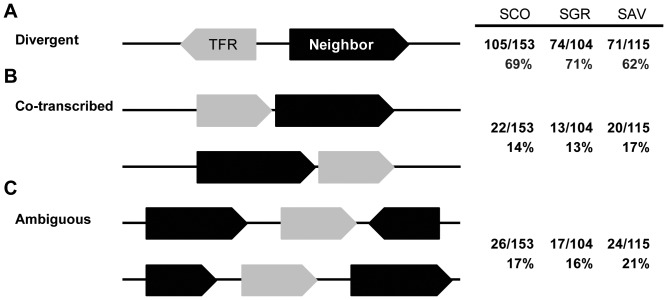
Classification of TFRs according to their relative orientation to the neighboring genes.372 TFRs in S. coelicolor (SCO, 153 TFRs), S. griseus (SGR, 104 TFRs), and S. avermitilis (SAV, 115 TFRs) were divided into three groups according to their genome context to neighbors. (A) 250 TFRs (105 in SCO, 74 in SGR, 71 in SAV) are encoded divergently to their neighbors. Here, a TFR-encoding gene is located on the left side for visualization purpose, but the positions of this gene and its divergent neighbor are interchangeable. (B) 55 TFRs (22 in SCO, 13 in SGR, 20 in SAV) are likely co-transcribed with their upstream or downstream genes as the intergenic DNAs separating them are ≤35 bp. (C) 67 TFRs (26 in SCO, 17 in SGR, 24 in SAV) show neither of the two aforementioned orientations.